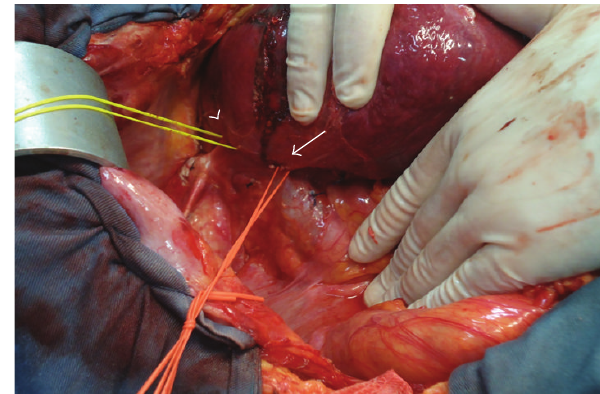
Figure 3: Retrohepatic inferior vena cava. RHV (arrow head) and inferior right hepatic vein (arrow) are encircled.